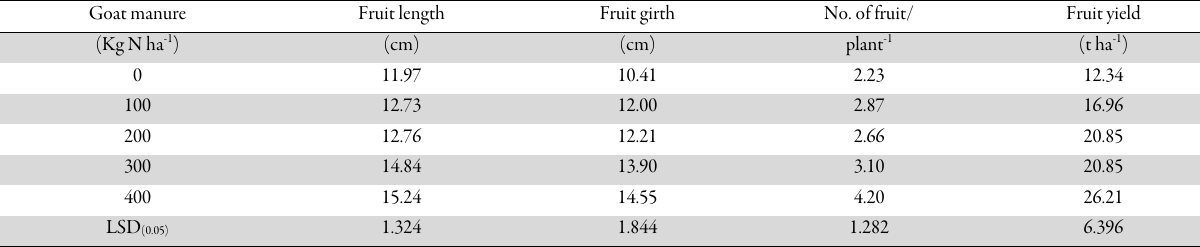
Table 2. Fruit yield and its components of C. sativum as influenced by different rate of goat manure application Goat manure